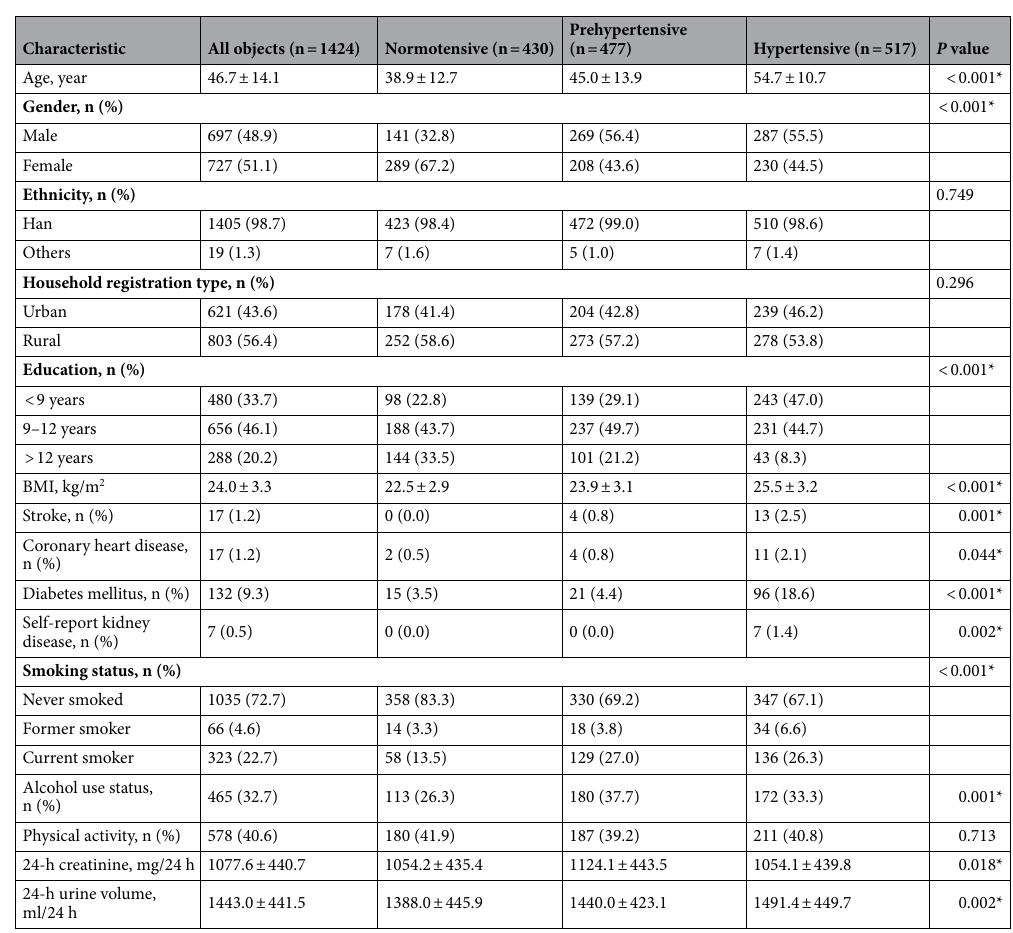
Table 1. Participant characteristics by hypertensive status among Chinese adults aged 18 to 69 years. a Sample sizes (n), means and prevalence are unweighted. * P < 0.05.